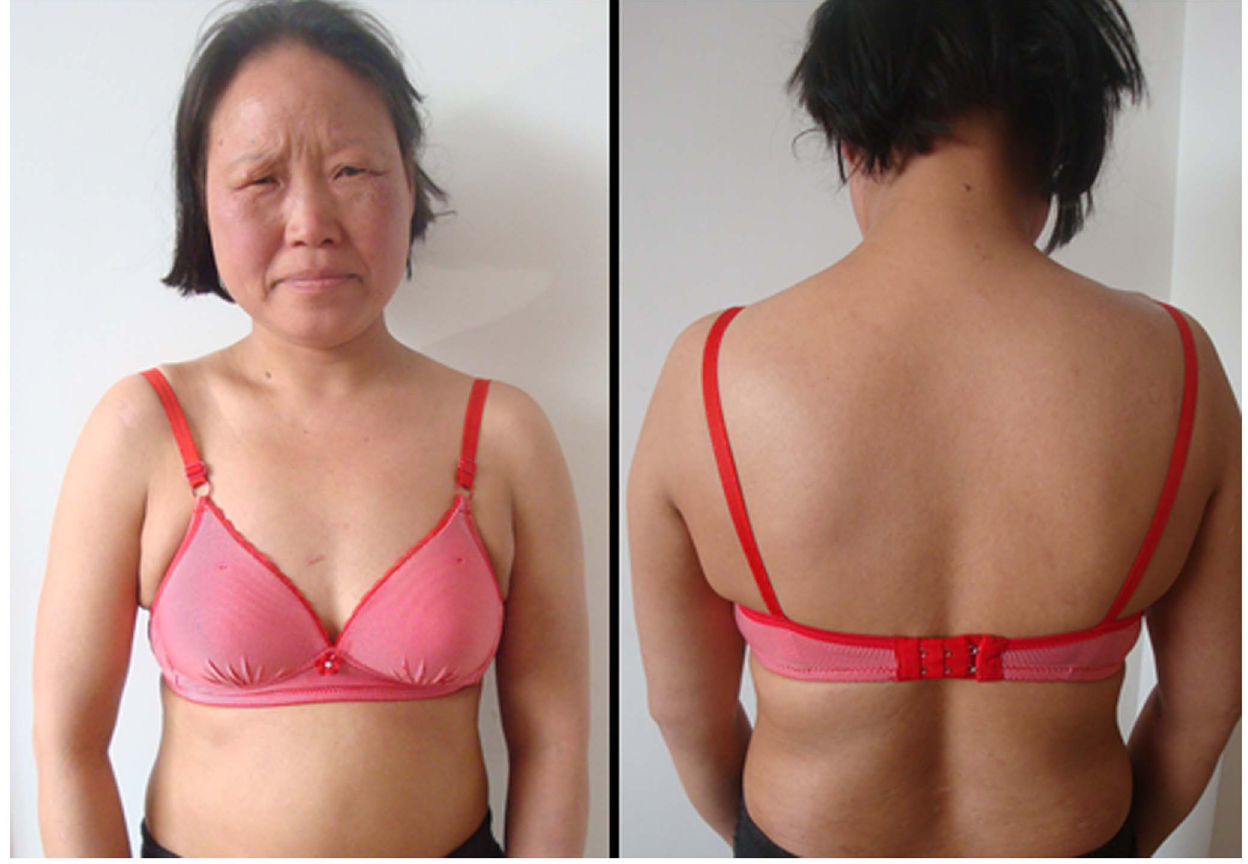
Figure 5. Clinical manifestations of the second patient after the treatment. The rash disappeared totally. doi:10.1371/journal.pntd.0003130.g005 PLOS Neglected Tropical Diseases |